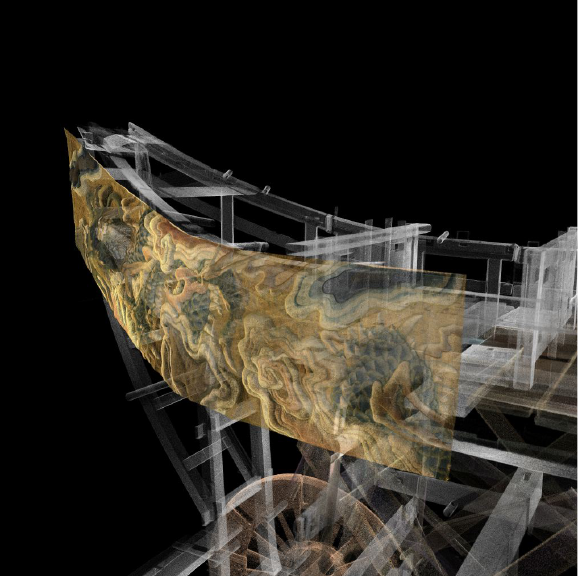
Figure 9. Transparent fused visualization of a high-resolution